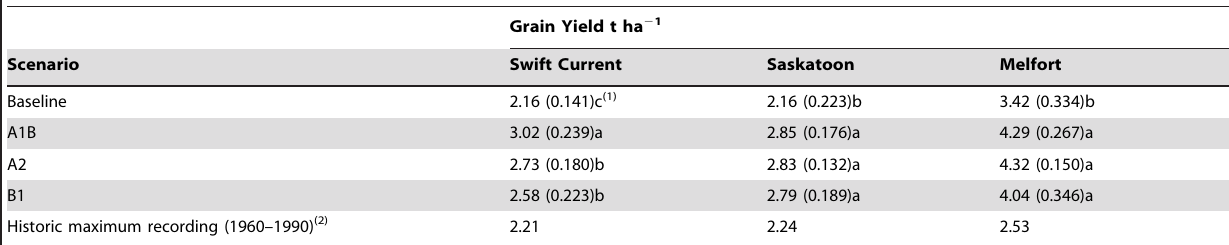
Table 6. Effects of climate change on grain production of